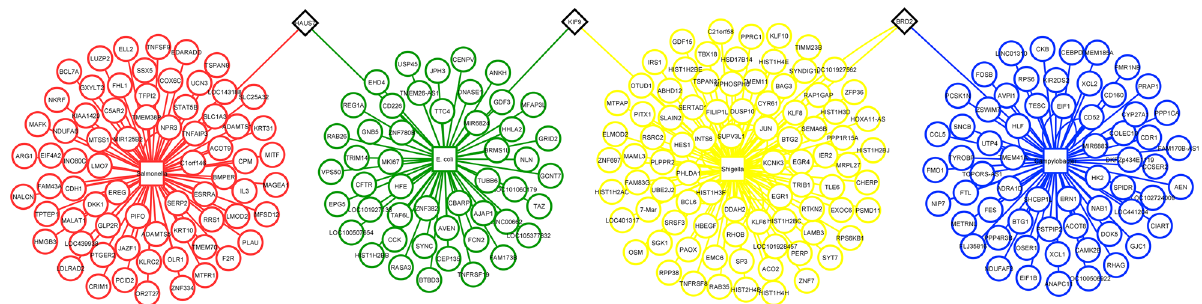
Figure 2. The common upregulated DEGs (black colored diamond boxes) found in the pathogenesis of four bacterial species. DEGs from Salmonella, E. coli, Shigella, and Campylobacter infection are shown in red, green, yellow, and blue colors,